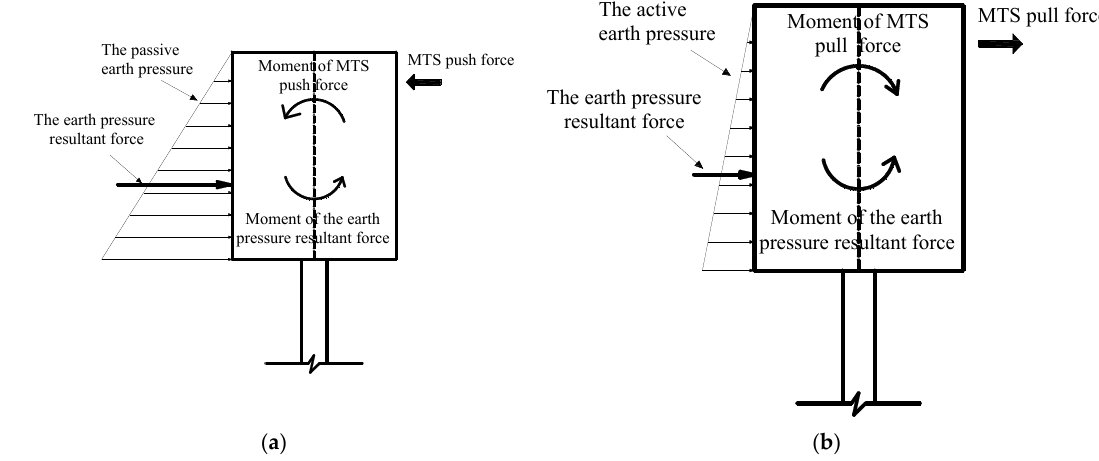
Figure 25. Angle diagram. ( a ) Positive direction. ( b ) Negative direction.